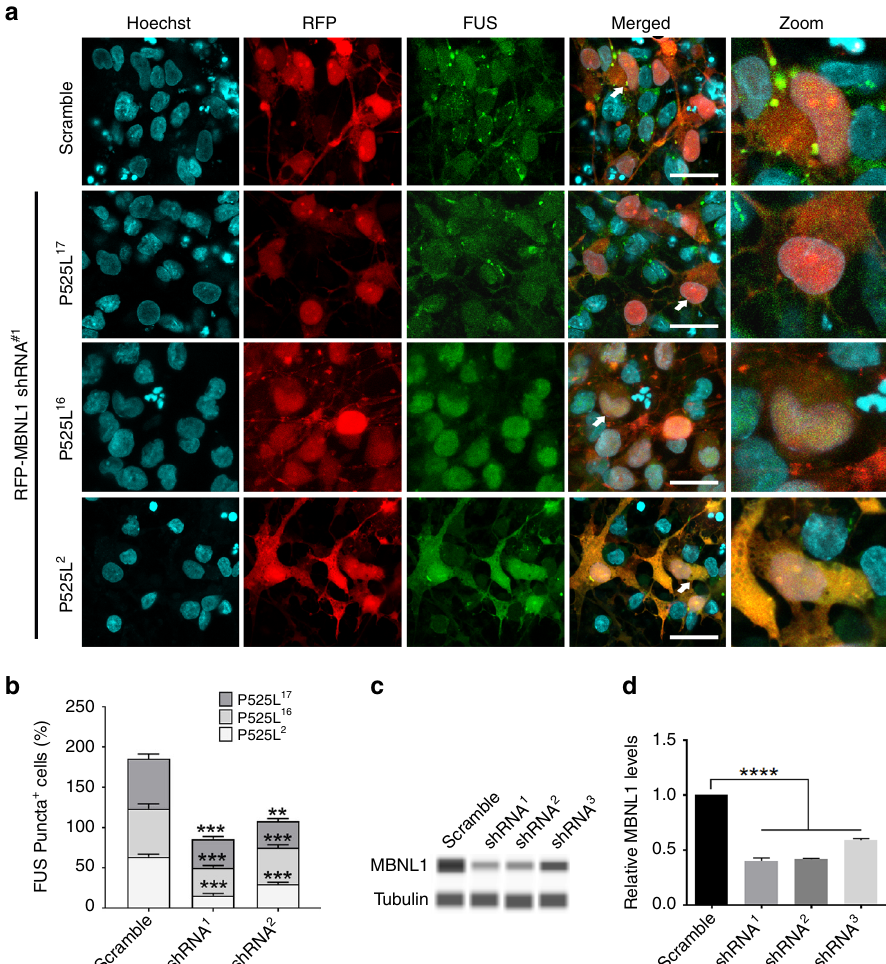
Fig. 7 MBNL1 downregulation attenuates FUS-positive SGs in iPSC-derived neurons. We used three different isogenic clones of FUS P525L iPSC line and these isogenic clones are labeled as 2, 16, and 17 as described previously 92 and were able to generate mixed cultures containing ~ 50% motor neurons (Hb9 + cells). a Representative confocal image showing FUS-positive stress granules in control and FUS P525L iPSC-derived neurons. b Quanti fi cation of the percentage of iPSC-derived neurons showing FUS-positive stress granules following lentiviral delivery of two different MBNL1 shRNAs and scramble control ( n = 50 – 60 neurons/line). c Protein capillary electrophoresis showing the ef fi cacy of MBNL1 knockdown by three independent MBNL1 shRNAs. d Quanti fi cation of protein capillary electrophoresis. Statistically signi fi cant differences were determined by two-tail, unpaired t test in B and two-way ANOVA followed by a Tukey post hoc analysis in c : ** p ≤ 0.01 are